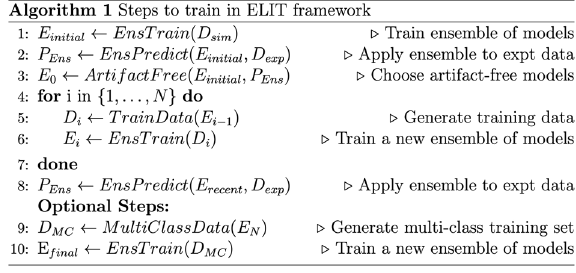
Fig. 1 Pseudocode for training models the ELIT framework. First (Line 1) an ensemble of models is trained on simulated data followed by applying each trained ensemble model (Line 2) to experimental data. The best (artifact-free) model or a subset of the best (artifact-free) models is then chosen (Line 3) and training data from a ‘ good ’ portion of predictions from the best model(s) is generated. The new training data is used for training a new ensemble of models and make predictions on the experimental data using the newly trained ensemble (Lines 4 – 8), which in turn is used to re fi ne the experimental training set for iterative re-training of the ensemble. As optional steps (Line 9, 10), a multi-class training set can be generated and used to train a new ensemble of models for multi-class classi fi